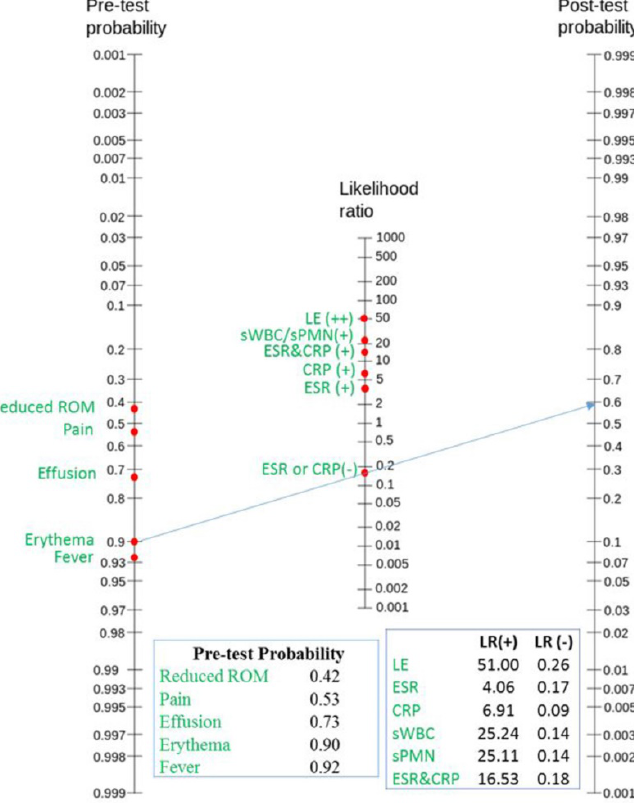
Figure 2. Fagan’s nomogram taking into account the pretest probability of patients based on their clinical presentation, together with the likelihood ratio of specific serum and synovial markers. The blue arrow represents a patient with a physical examination positive for erythema. Even though his serum markers within normal levels, he has a 60% probability for infection. He went on to having a joint aspiration, which grew S.aureus on three separate cultures. Range of Motion (ROM); Erythrocyte Sedimentation Rate (ESR); C-Reactive Protein (CRP); Synovial Fluid White Blood Cells (sWBC); Synovial Fluid Polymorphonuclear Leukocytes (sPMN); Leukocyte esterase (LE); Positive Likelihood Ratio (LR+) = Sensitivity / (1-Specificity); Negative likelihood ratio(LR-) =(1-Sensitivity) /